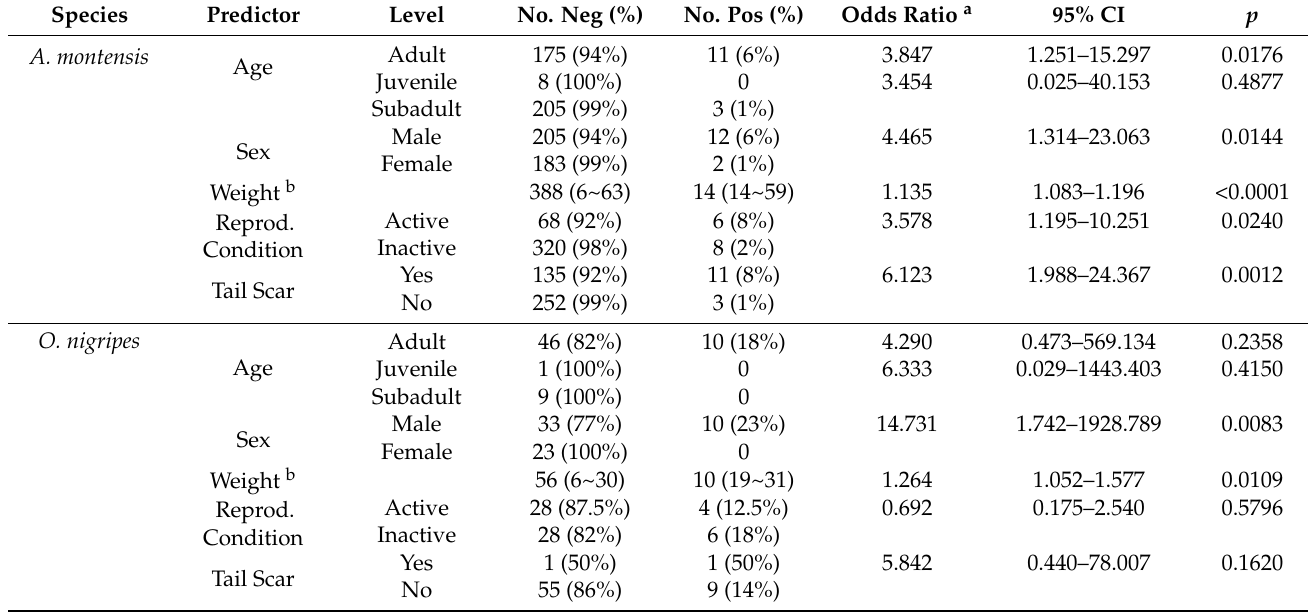
Table 4. Univariate logistic regression tests for the association of age, sex, weight, reproduction condition, and tail scar with the presence of antibodies to Andes orthohantavirus . Outputs of each model are the odds ratio, 95% confidence intervals (CI), and associated p values. We also report the number of seropositive and seronegative individuals for each predictor level and the proportion of individuals at each level (expressed as a